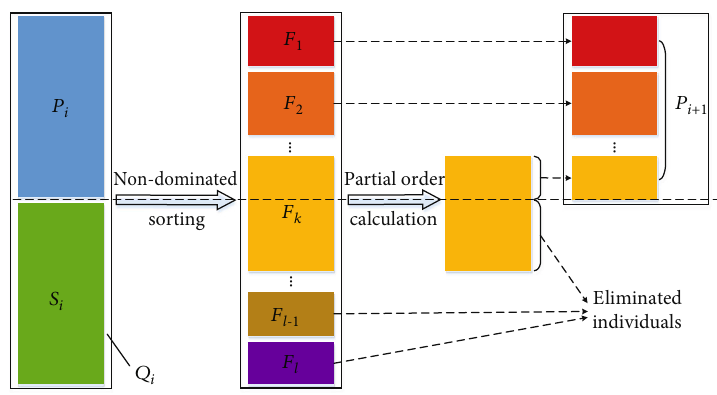
Figure 8: New population generation mechanism in INSGA.